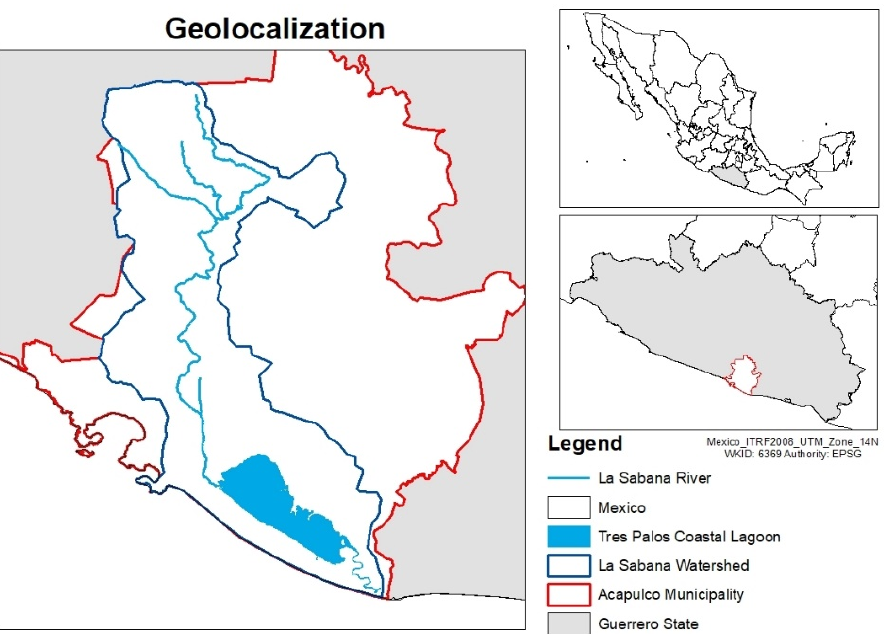
Figure 1. The Tres Palos coastal lagoon located in the Acapulco Municipality of the state of Guerrero, Mexico, on the Pacific Ocean coast.